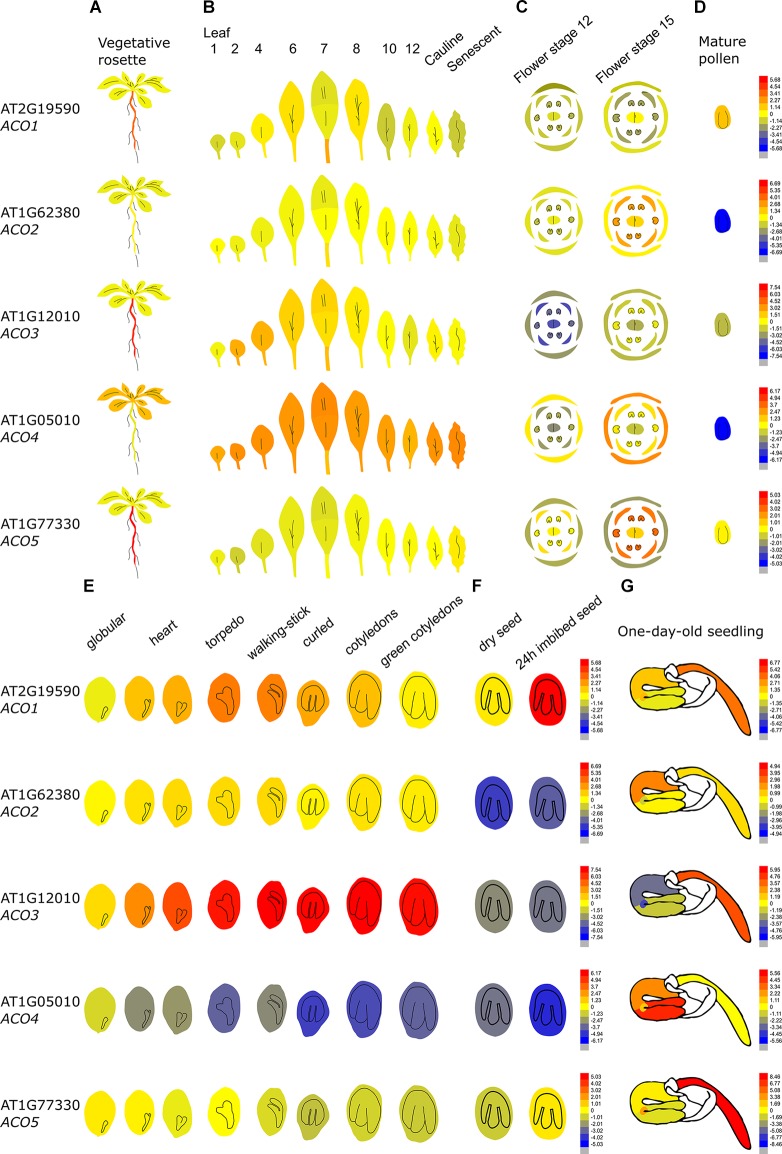
Tissue-specific and developmental expression profiles of the five Arabidopsis ACOs. Data is adapted from the eFP browser. The color scale depicts a Log2 fold expression range (Waese et al., 2017). (A) Expression in the vegetative rosette and the root, (B) the different leaves, (C) the different flowering organs, (D) mature pollen, (E) the different stages of embryogenesis, (F) the dry and imbibed seed, and (G) a 1-day-old seedling (Nakabayashi et al., 2005; Schmid et al., 2005; Klepikova et al., 2016).